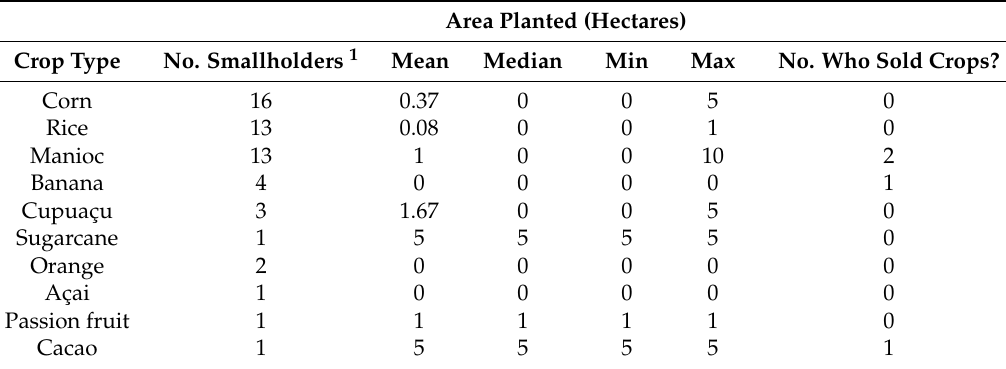
Table 2. Cropping system characteristics for primary crops in 2010 ( N =